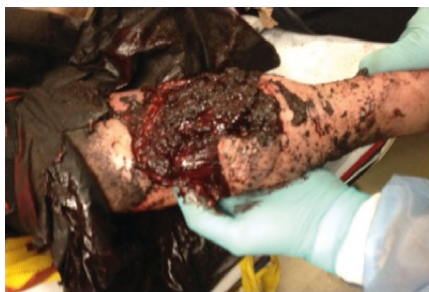
Figure 1: Injury at presentation in trauma bay, demonstrating gross contamination of the open fracture.